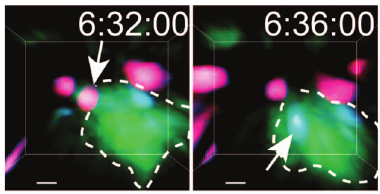
Selected PLOS Biology research articles are accom- panied by a synopsis written for a general audience to provide non-experts with insight into the significance of the published